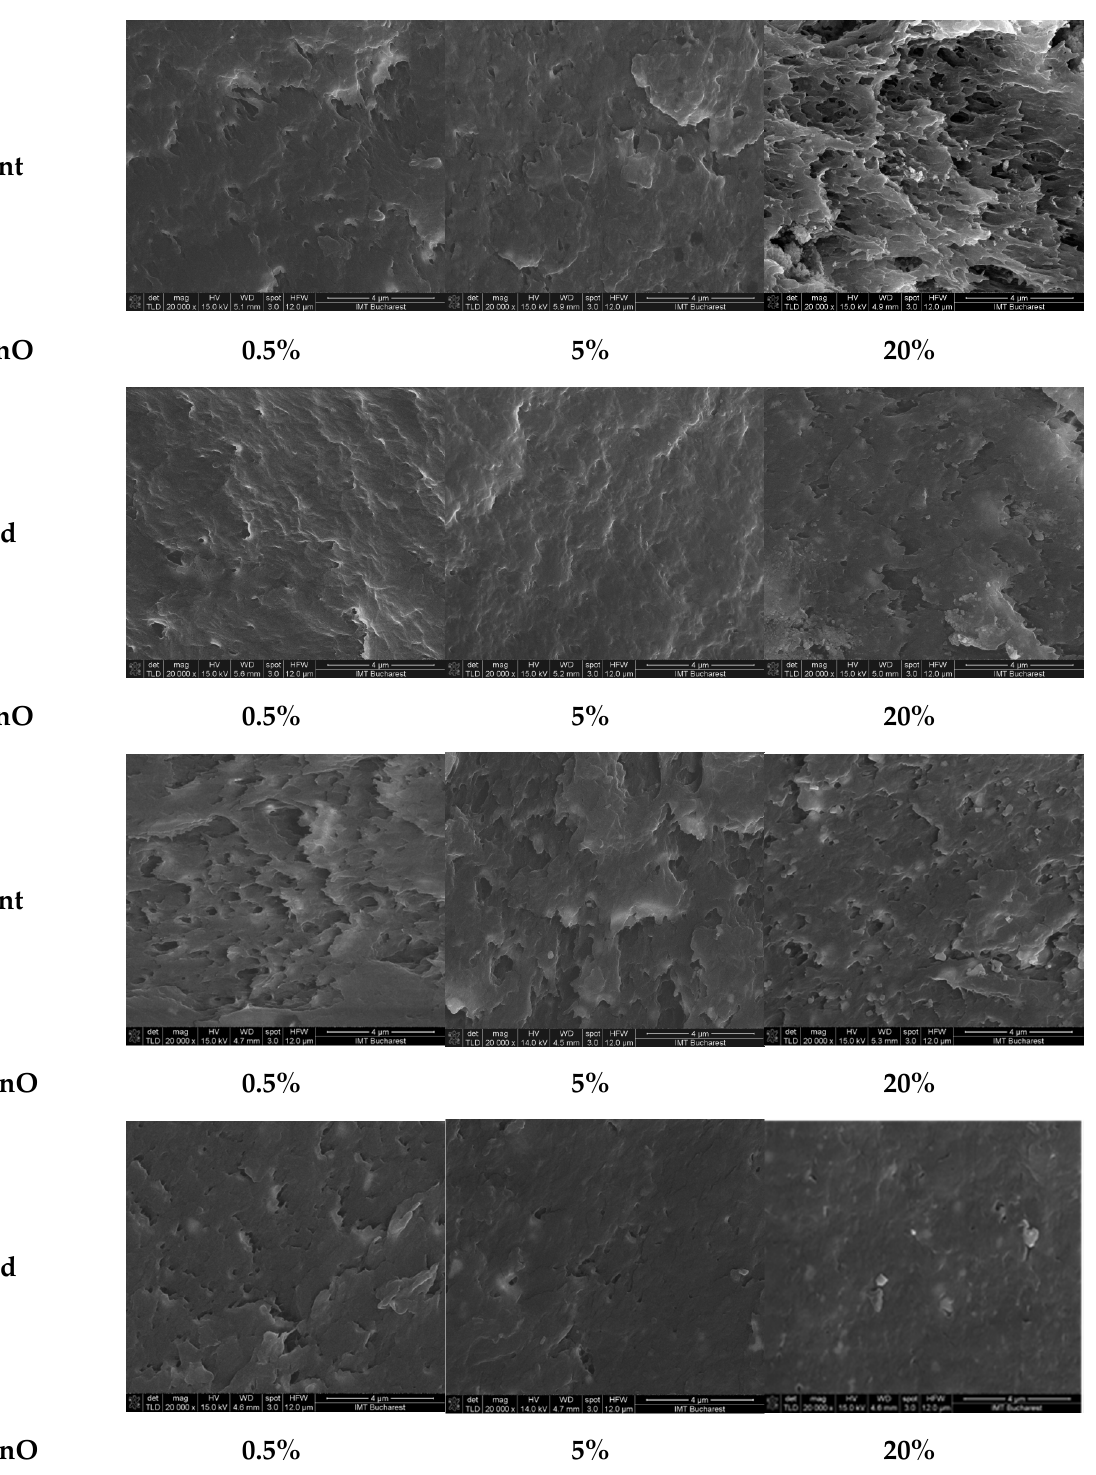
Figure 5. SEM images presenting examples of the structures of the 0.5%, 5% and 20% nano- and micro-ZnO-ABS filaments and printed composite materials. Magnification ×20,000. Scale is 4 μ m for all images.